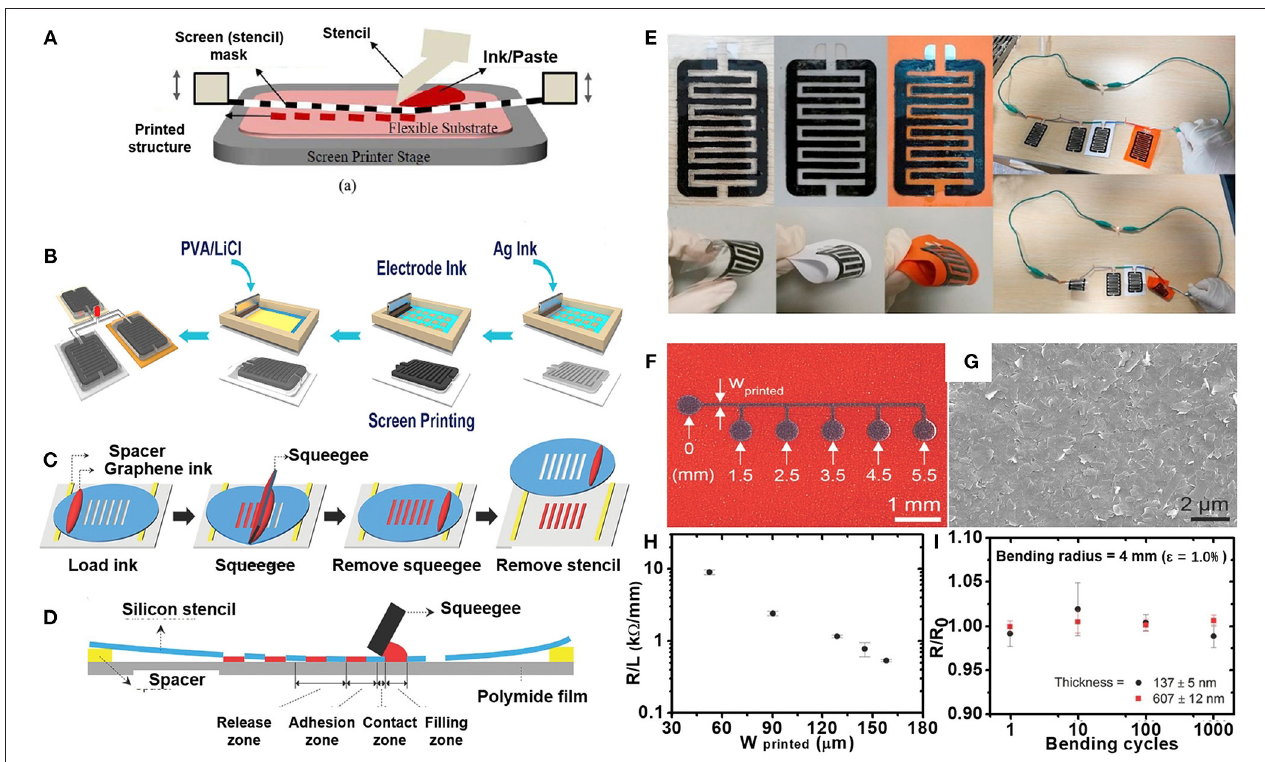
FIGURE 5 | (A) The illustration of screen printing technology (Khan et al., 2015). Reproduced with the permission of the IEEE. (B) The diagram of fabrication of the transistor ( Lu et al., 2017). Reproduced with the permission of 2017 Elsevier B.V. (C) Schematic fabrication process of electrodes using screen printing technology and graphene ink. (D) Cross-sectional diagram of the screen printing technique ( Hyun et al., 2015a). Reproduced with the permission of 2015 WILEY-VCH Verlag GmbH & Co. KGaA, Weinheim. (E) Optical photographs of printed electrodes fabricated using the screen-printing technology shown in (B) (Lu et al., 2017). Reproduced with the permission of 2017 Elsevier B.V. (F) Optical micrograph of printed graphene lines with various printed widths. (G) SEM images of the graphene line surface. (H) Resistance per unit length of the graphene as a function of printed width. (I) Relative resistance changes of the graphene lines with